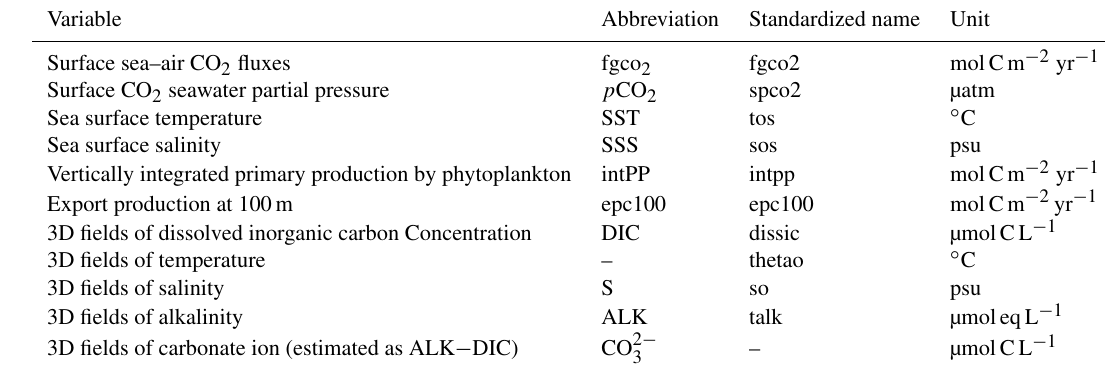
Table 1. Ocean variables used in this study. The full name, the abbreviation, standardized CMIP6 name, and the unit of each variable are all also given.